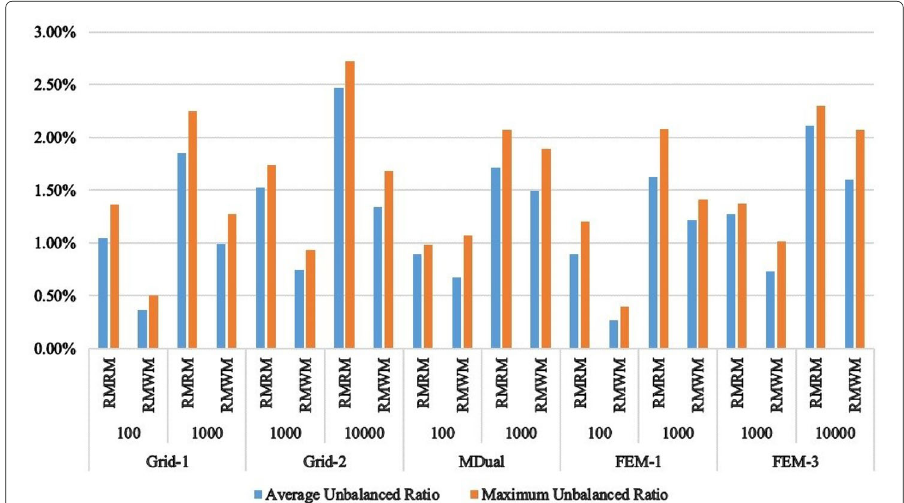
Fig. 1 The unbalanced ratios of the two types of maximal